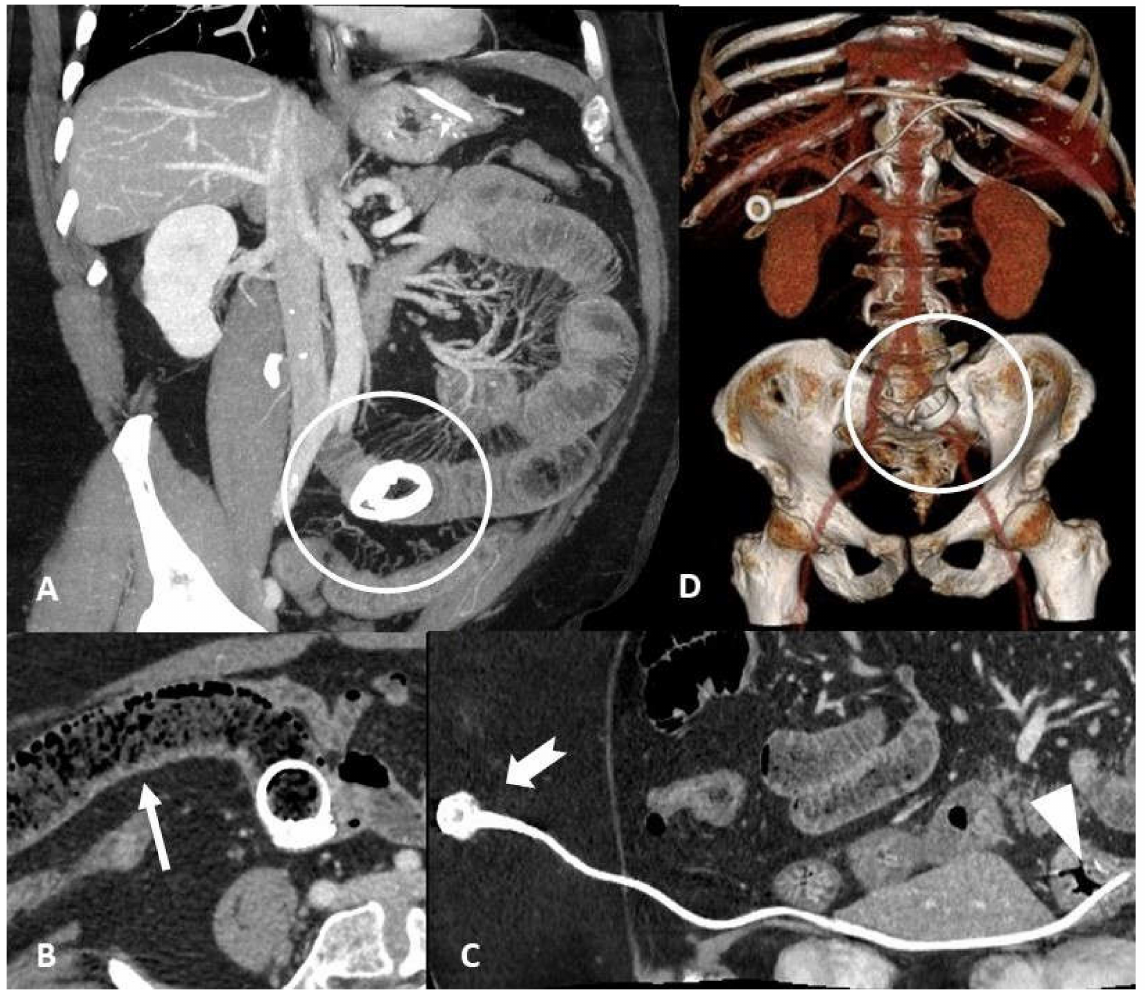
Figure 8. Obstruction. Sixty-four-year-old male with a 3-day history of abdominal pain, constipation, vomiting, and a history of surgery with sleeve gastrectomy and LAGB (laparoscopic adjustable gastric banding) insertion for morbid obesity. Contrast-enhanced CT maximum intensity projection images show ( A ) jejunum dilatation with transition point in mesogastrium caused by gastric band displacement; ( B ) marked dilation of the upstream loop by fecaloid material stasis (arrow) indicates mechanical obstruction. Contrast-enhanced CT multiplanar reconstruction scans ( C ) show port localization in the subcutaneous tissue of the anterior abdominal wall (notched arrow) and the tip of the connecting tube in the gastric cavity (arrowhead). CT 3D-reconstruction ( D ) better shows device disconnection, migration, and integrity of the two